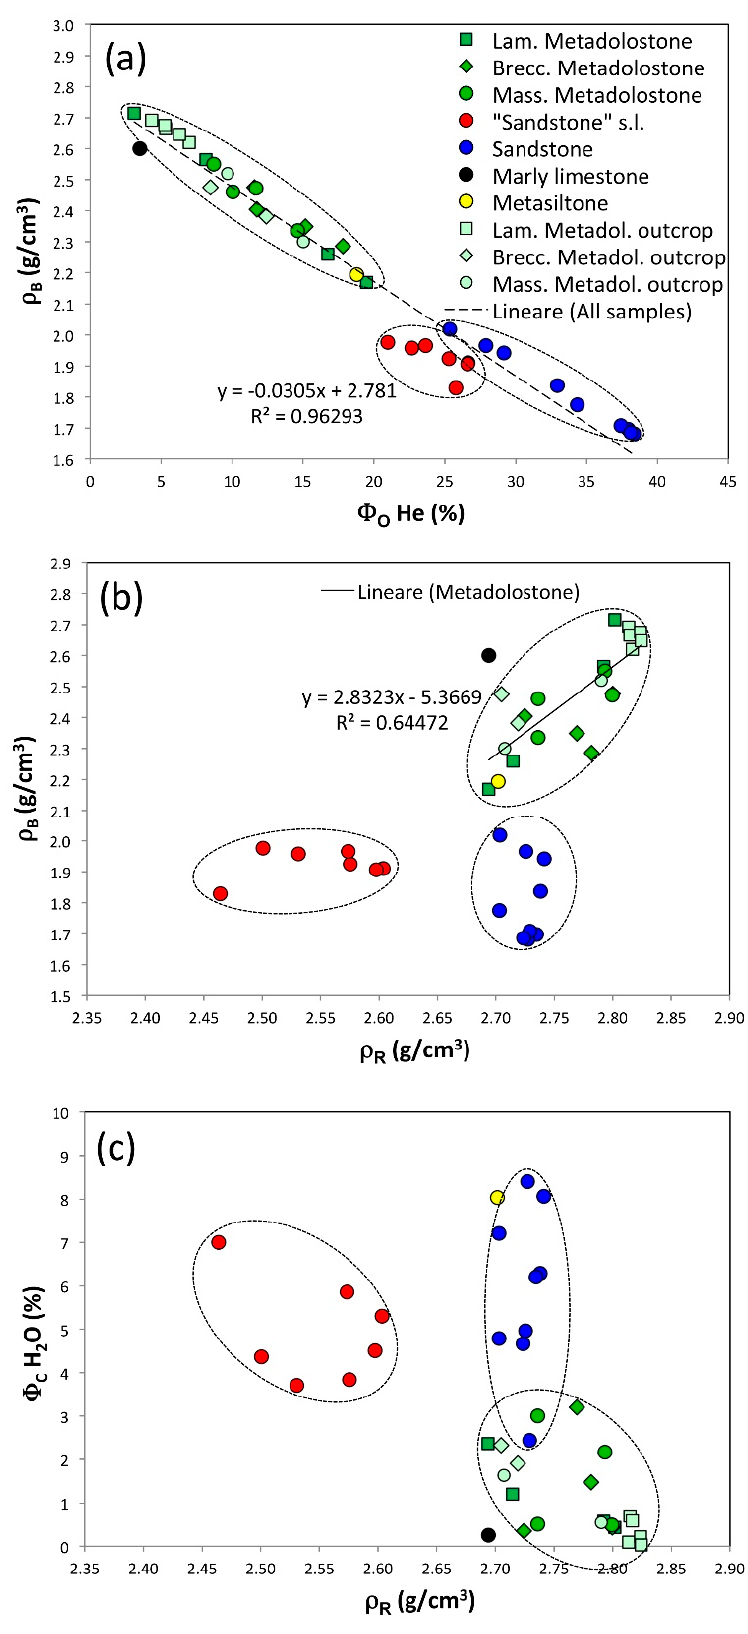
Figure 11. ( a ) Helium open porosity ( Φ O H 2 O) vs. bulk density ( ρ B ); ( b ) real density ( ρ R ) vs. bulk density ( ρ B ); ( c ) real density ( ρ R ) vs. water closed porosity ( Φ C H 2